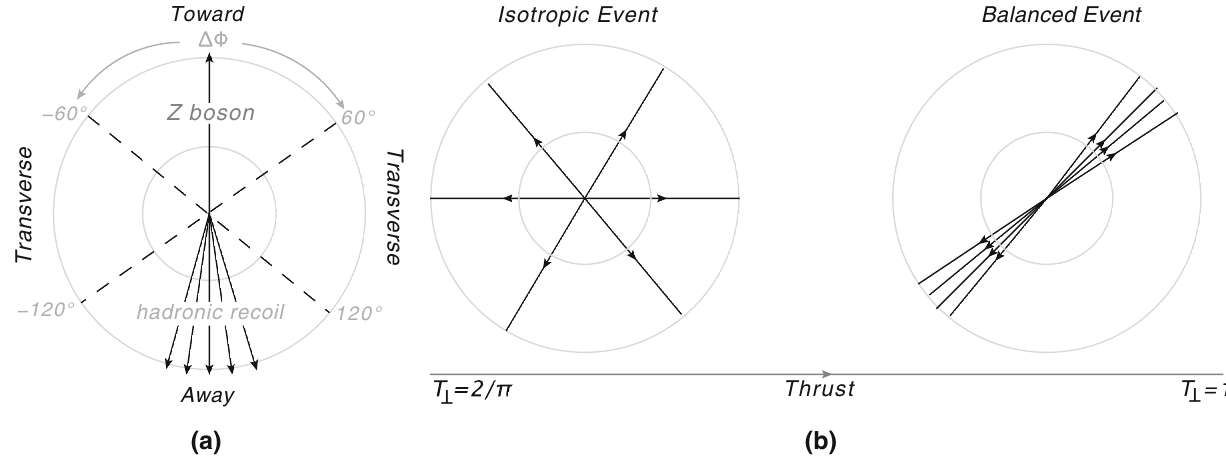
Fig. 1 a Illustration of away, transverse, and towards regions in the transverse plane defined relative to the direction of the Z boson. b Illus- tration of an isotropic and a balanced event topology in the transverse